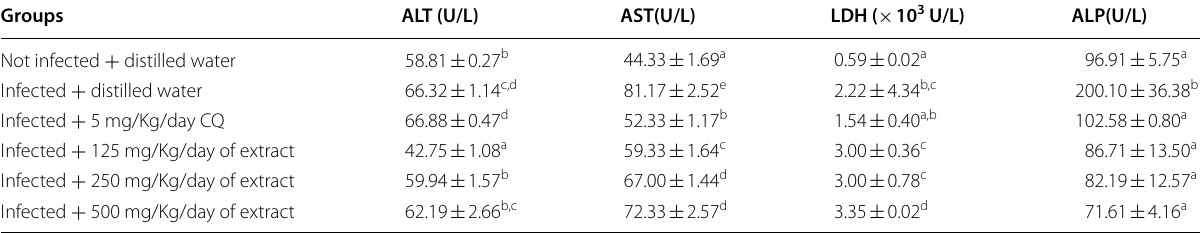
Values are mean S.E.M ( n 8) ± = CQ chloroquine; ALT alanine aminotransferase; AST aspartate aminotransferase; LDH lactate dehydrogenase; ALP alkaline phosphatase Values with different alphabets superscripts in the same column are significantly different at P < 0.05